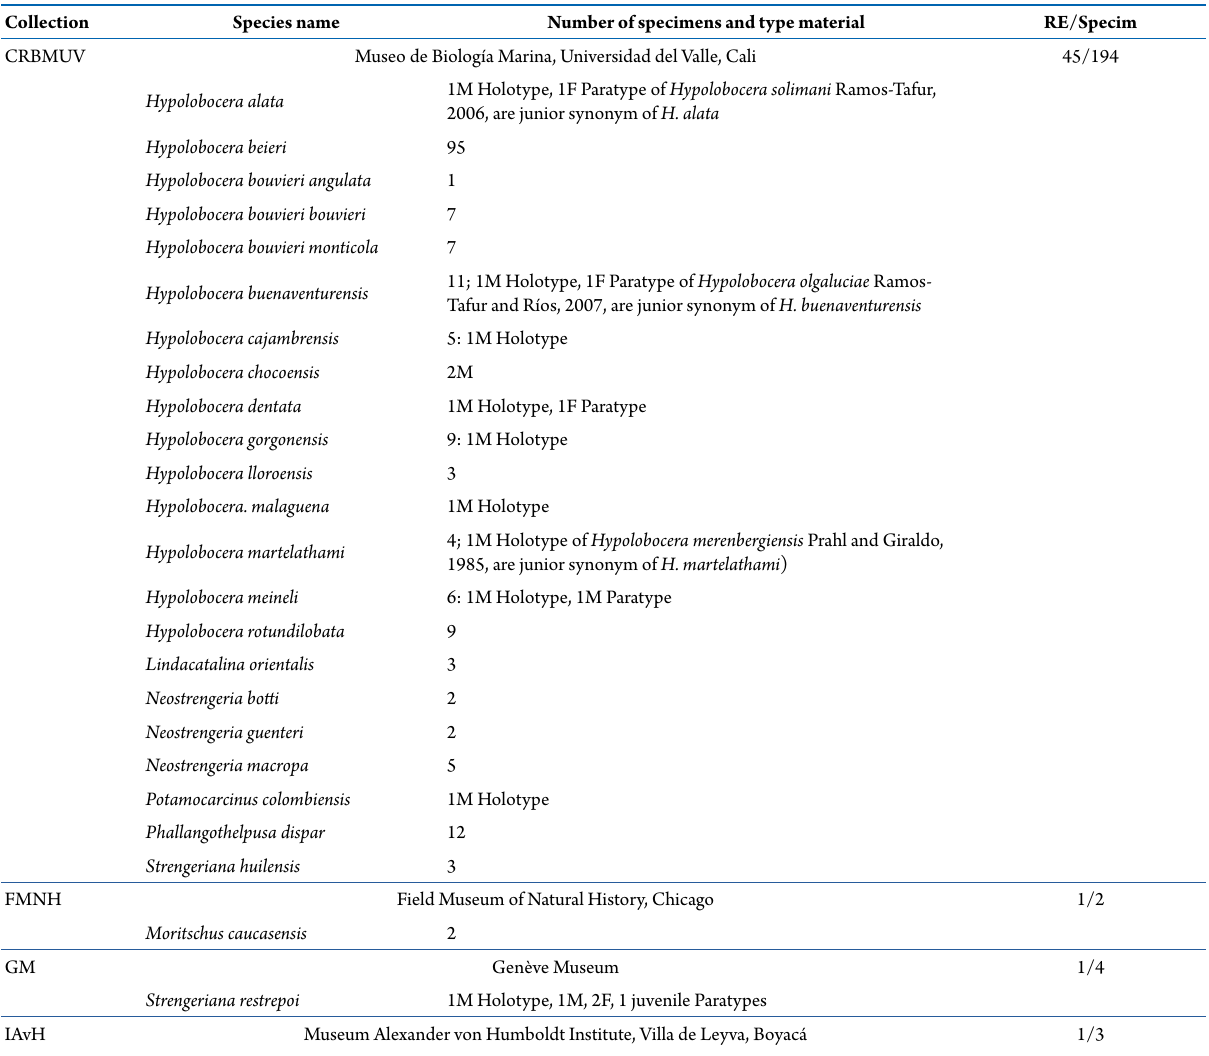
Table 1. Museums and research institutions whose collections of the family Pseudothelphusidae have been used for the construction of the database. The last column includes the numbers of records (RE) and specimens (Specim). The abbreviations male (M) and female (F) are